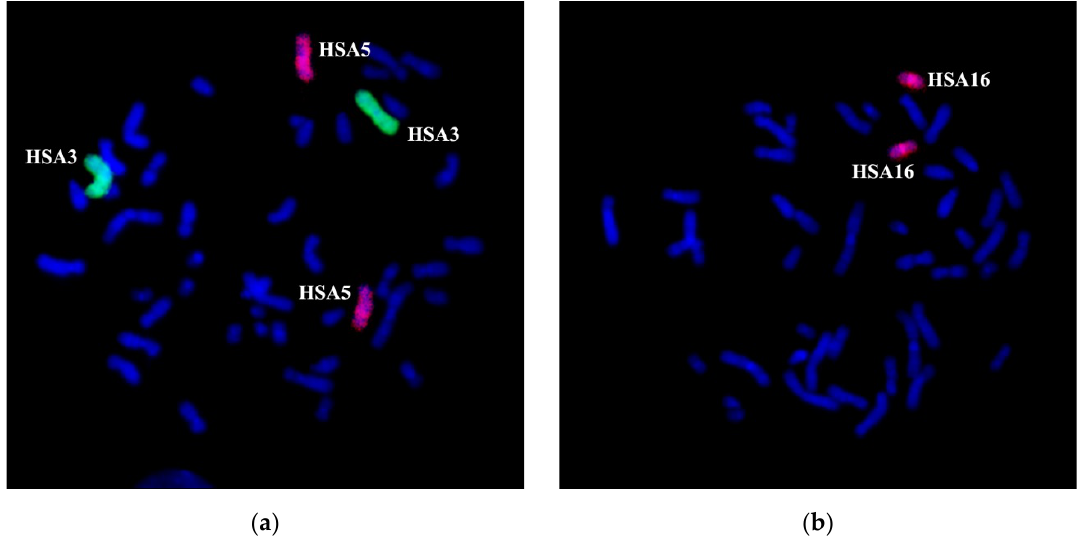
Figure 2. Two-color chromosomal in situ suppression (CISS) hybridization with WCP3 (green) / WCP5 (red) ( a ) and WCP16 (red) ( b ) on metaphase chromosomes of a healthy donor. Whole chromosome painting probes (WCPs) intensely painted original chromosomes. The general staining of chromosomes with 4’,6-Diamidino-2-phenylindole dihydrochloride (DAPI) in blue. Chromosomes are marked as human chromosome 3 (HSA3), human chromosome 5 (HSA5), and human chromosome 16 (HSA16).